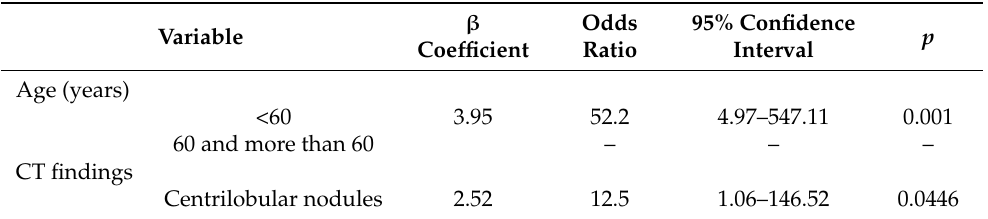
Table 3. Independent predictor variables for Mycoplasma pneumoniae pneumonia of the multivari- able model.